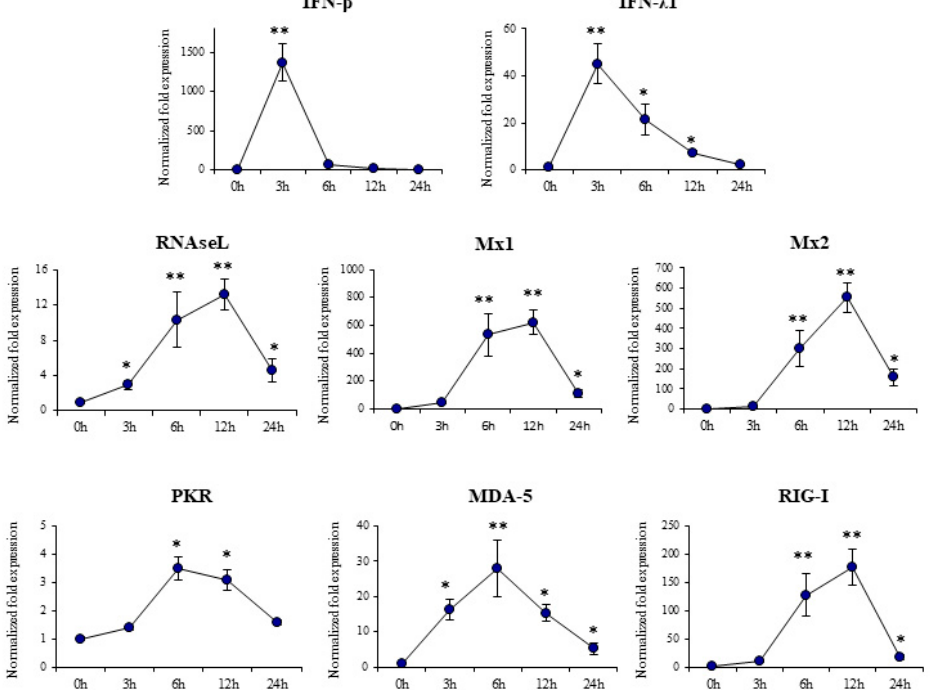
Figure 1. Expression of interferons and interferon-induced antiviral genes in porcine alveolar macrophages after the challenge with the Toll-like receptor 3 (TLR3) agonist poly(I:C). The expression of IFN- β , IFN- λ 1 , RNAseL , Mx1 , Mx2 , PKR , MDA-5 and RIG-I were analyzed by qPCR at the indicated time points after poly(I:C) challenge. The results represent data from three independent experiments. Significant differences when compared to unchallenged control porcine alveolar macrophages (time 0 h). * ( p < 0.05), ** ( p < 0.01).